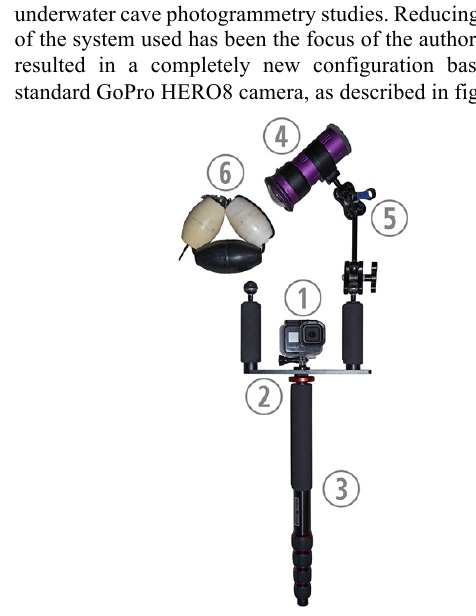
Figure 6 . Compact photogrammetric setup for underwater caves including: (1) GoPro HERO8 camera ; (2) Aluminium tray ; (3) Telescopic, aluminium mono-tray with purge holes ; (4) 15,000 Lumen Keldan light ; (5) Adjustable light arm with two